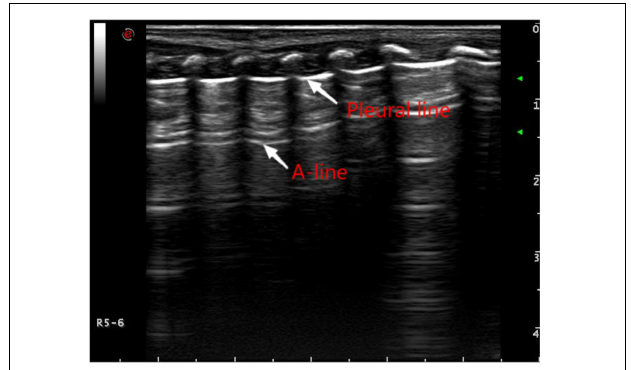
FIGURE 1 | Pulmonary ultrasound findings of normal newborns. Pulmonary ultrasound shows that the pleural line and A-line are clear, smooth, and parallel like “bamboo